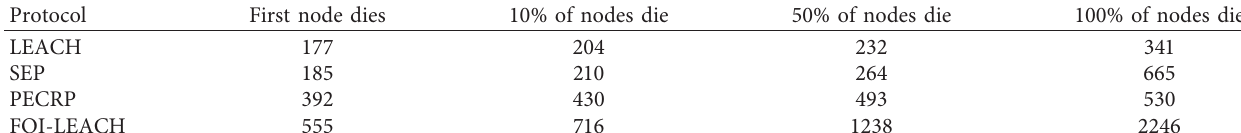
Table 4: Statistics number of rounds of dead nodes of the four protocols with power supply.